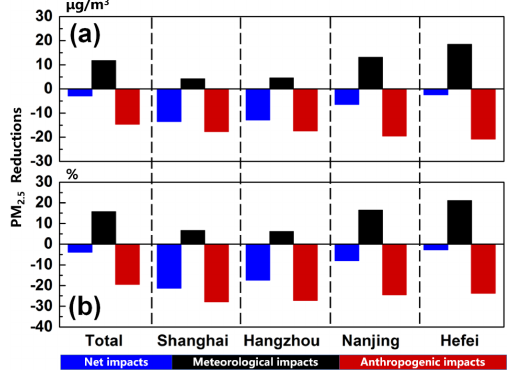
Figure 6. The impacts of anthropogenic emission controls and me- teorological variations on PM 2 . 5 concentrations in January from 2016 to 2019 over the whole domain as well as in four represen- tative cities (i.e., Shanghai, Hangzhou, Nanjing, and Hefei). Pan- els (a) and (b) refer to the changes in absolute values and relative percentages, respectively. Figure 7. The impacts of anthropogenic emission controls and in-